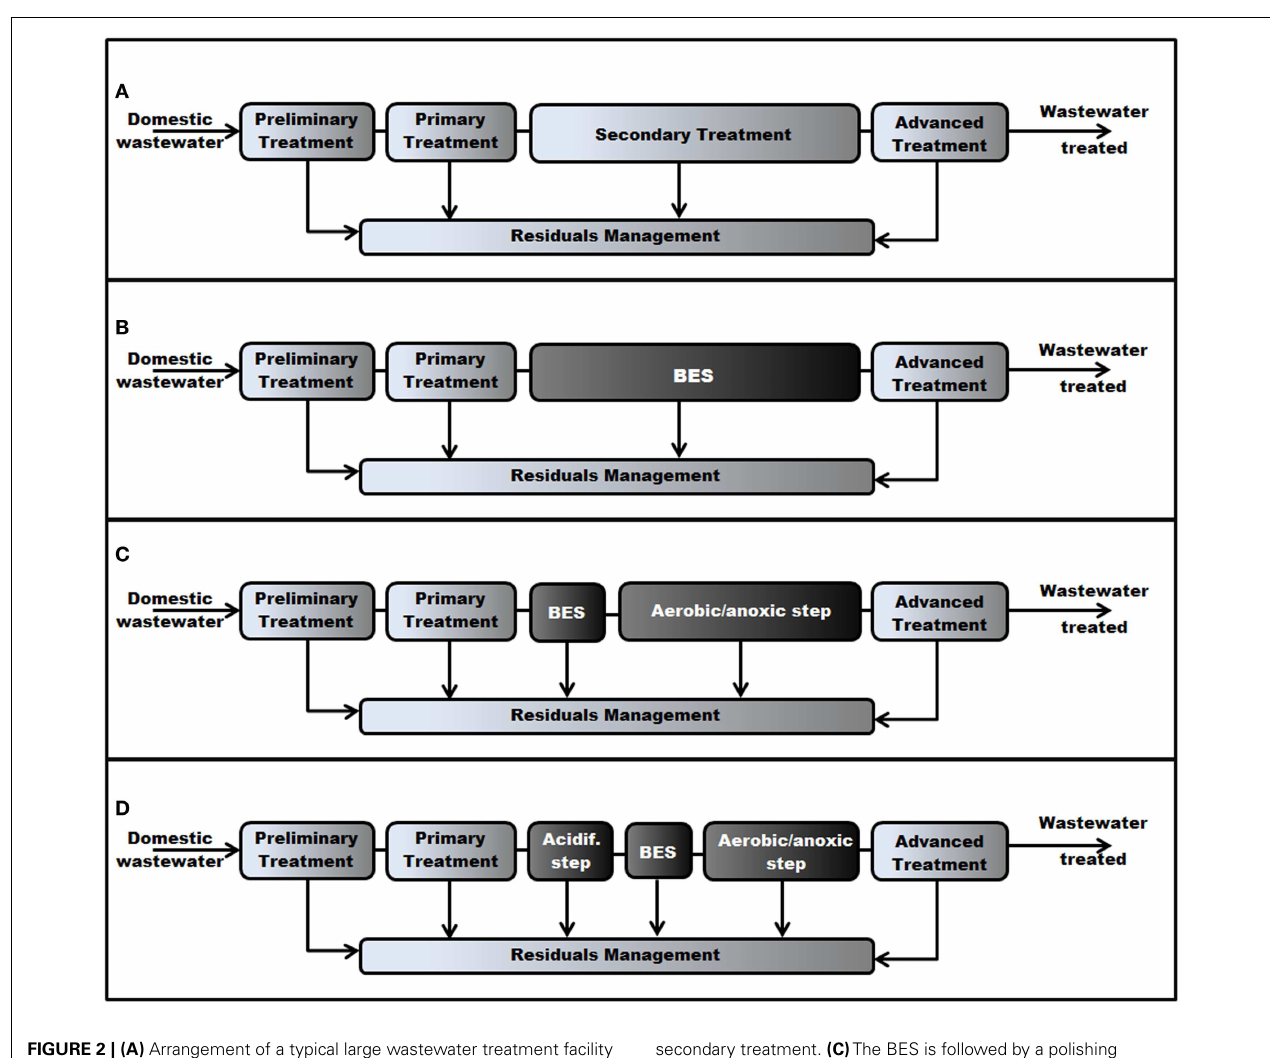
FIGURE 2 | (A) Arrangement of a typical large wastewater treatment facility integrating a BES. (A) Traditional arrangement with no BES (drawn with modifications fromVesilind, 2003). (B) The BES replaces the bioreactor in the